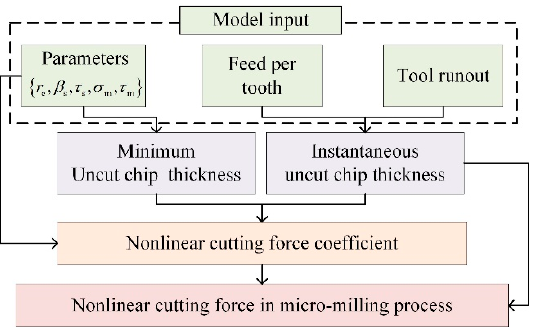
Figure 3. Model of the proposed micro-milling force embedded with the novel MUCT model.